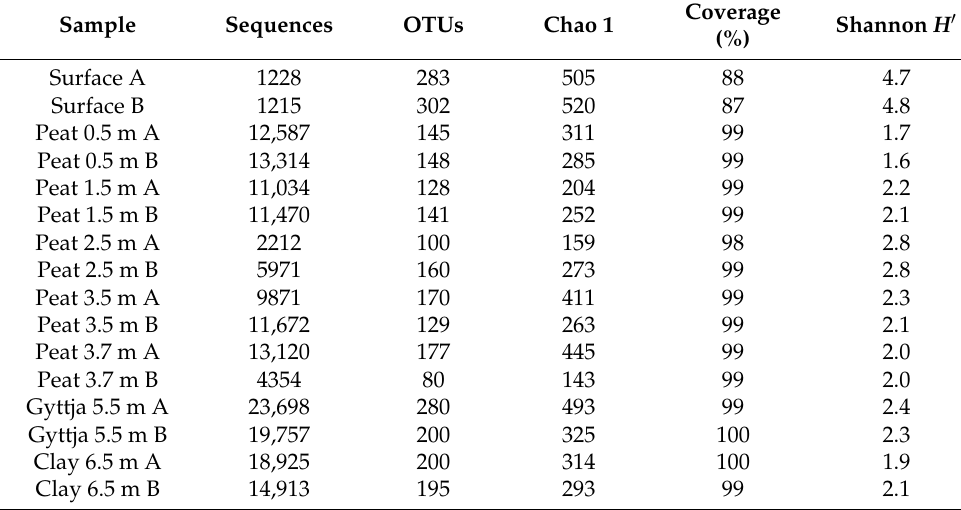
Table 4. The total number of archaeal 16S rRNA gene sequence reads (Sequences), and the number of observed (OTUs) and Chao1 estimated archaeal OTUs (Chao1), Good’s coverage (%) of detected OTUs estimated from the Chao1 (Coverage), and Shannon’s diversity indices (Shannon H (cid:48) ) calculated from the rarefied (1000 sequence reads) data. Samples A and B are the duplicate samples from the same layer and the DNA was extracted using Extraction Buffer SL1 and SL2 for sample A and B, respectively.